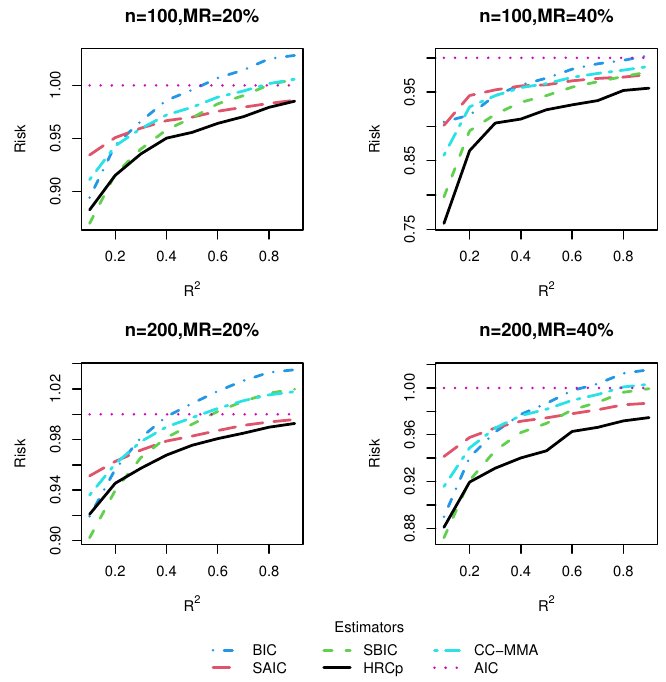
Figure 6. Risk comparisons for Design